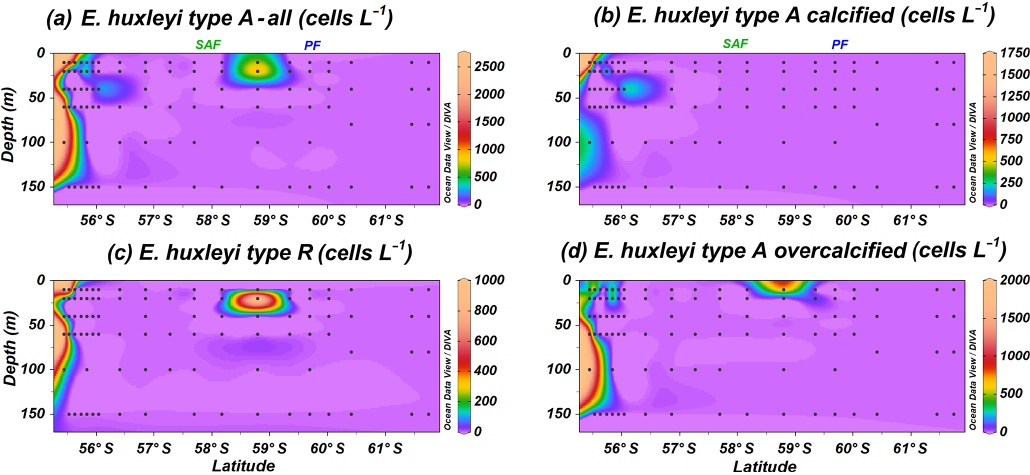
Figure 4. Location of the PS97 CTD stations studied showing the number of coccospheres per litre of (a) Emiliania huxleyi type A group, (b) E. huxleyi type A moderately calcified, (c) E. huxleyi type R and (d) E. huxleyi overcalcified. The Subantarctic Front (SAF) and the Polar Front (PF), according to Orsi et al. (1995), are